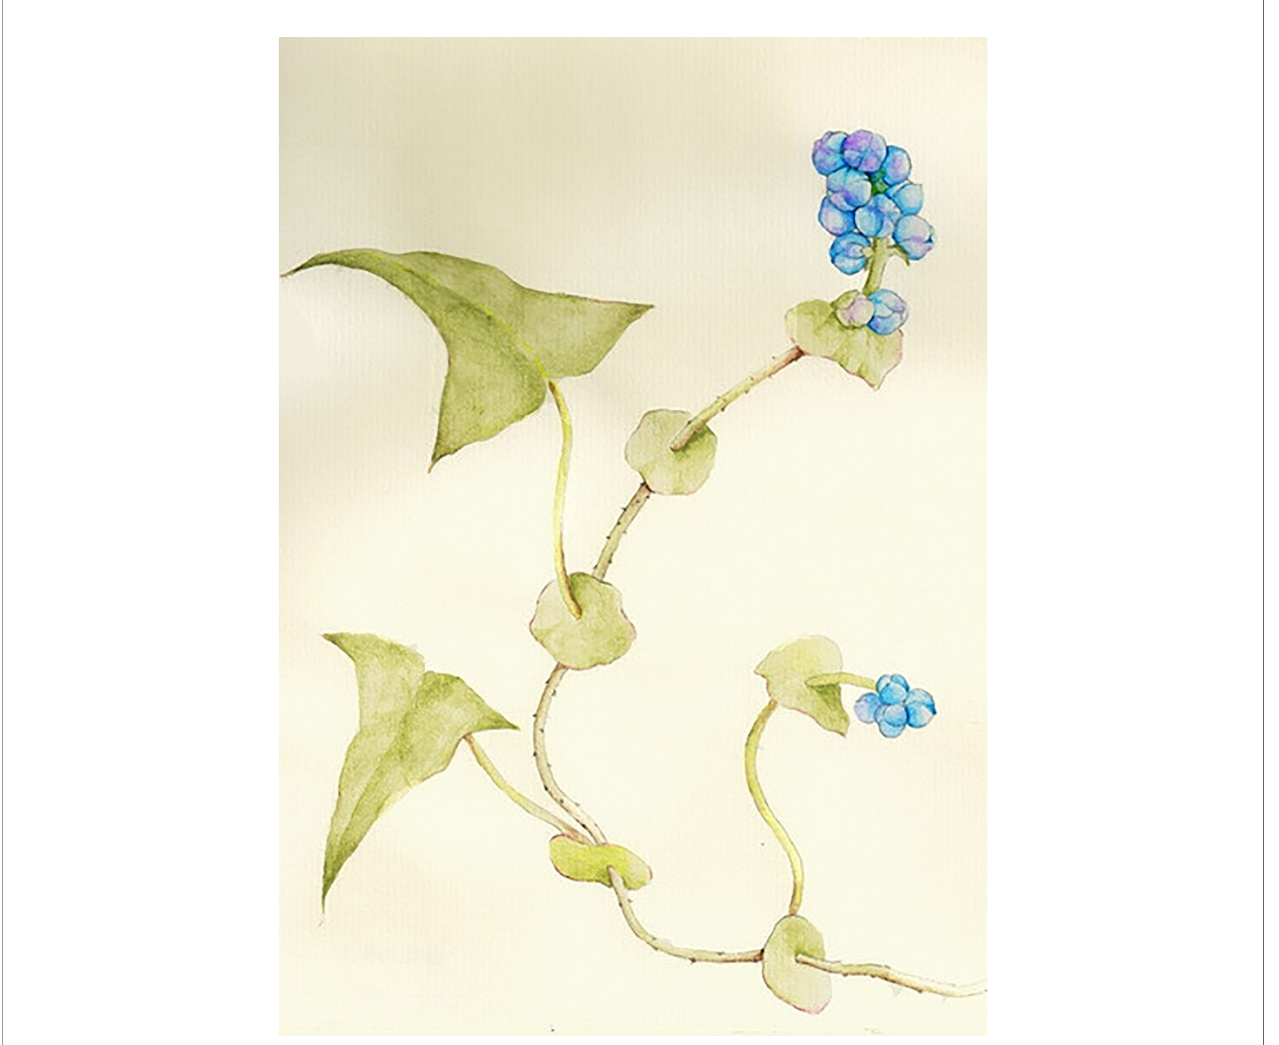
FIGURE 1 | The whole